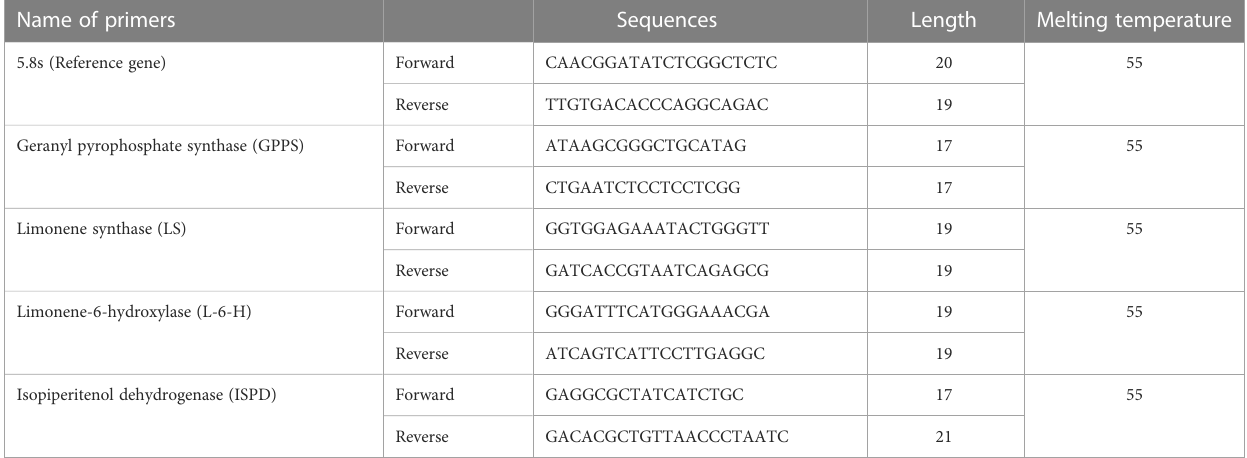
TABLE 2 Table showing the details of primers used for gene expression